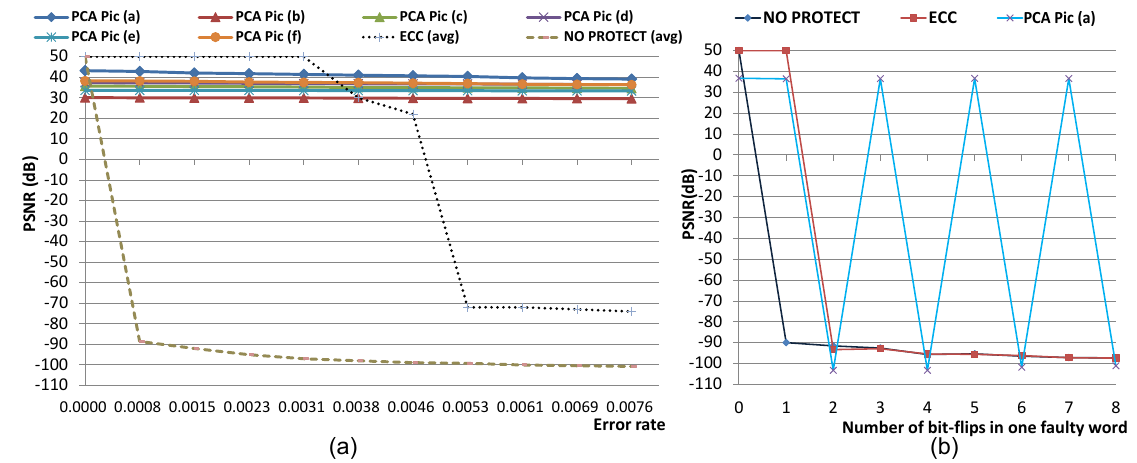
Figure 11. Single-bit ( a ) and multiple-bit ( b ) error rates versus PSNR under no protection, ECC and proposed PCA